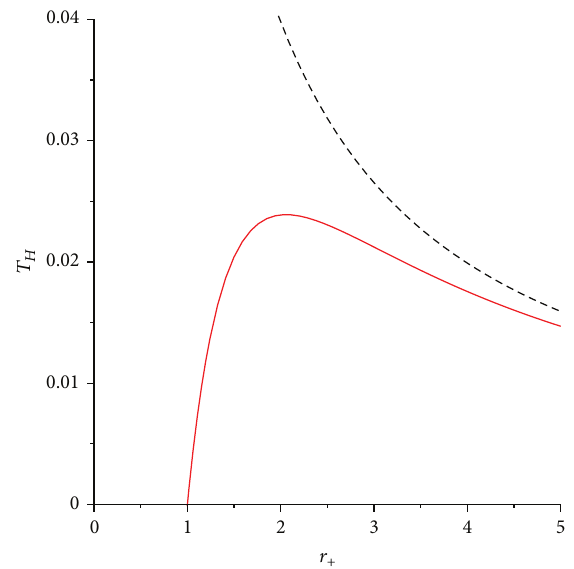
Figure 3: The solid curve represents the Hawking temperature 𝑇 𝐻 and as a function of the horizon radius 𝑟 + in Planck units. The dotted curve represents the corresponding classical result in terms of the Schwarzschild